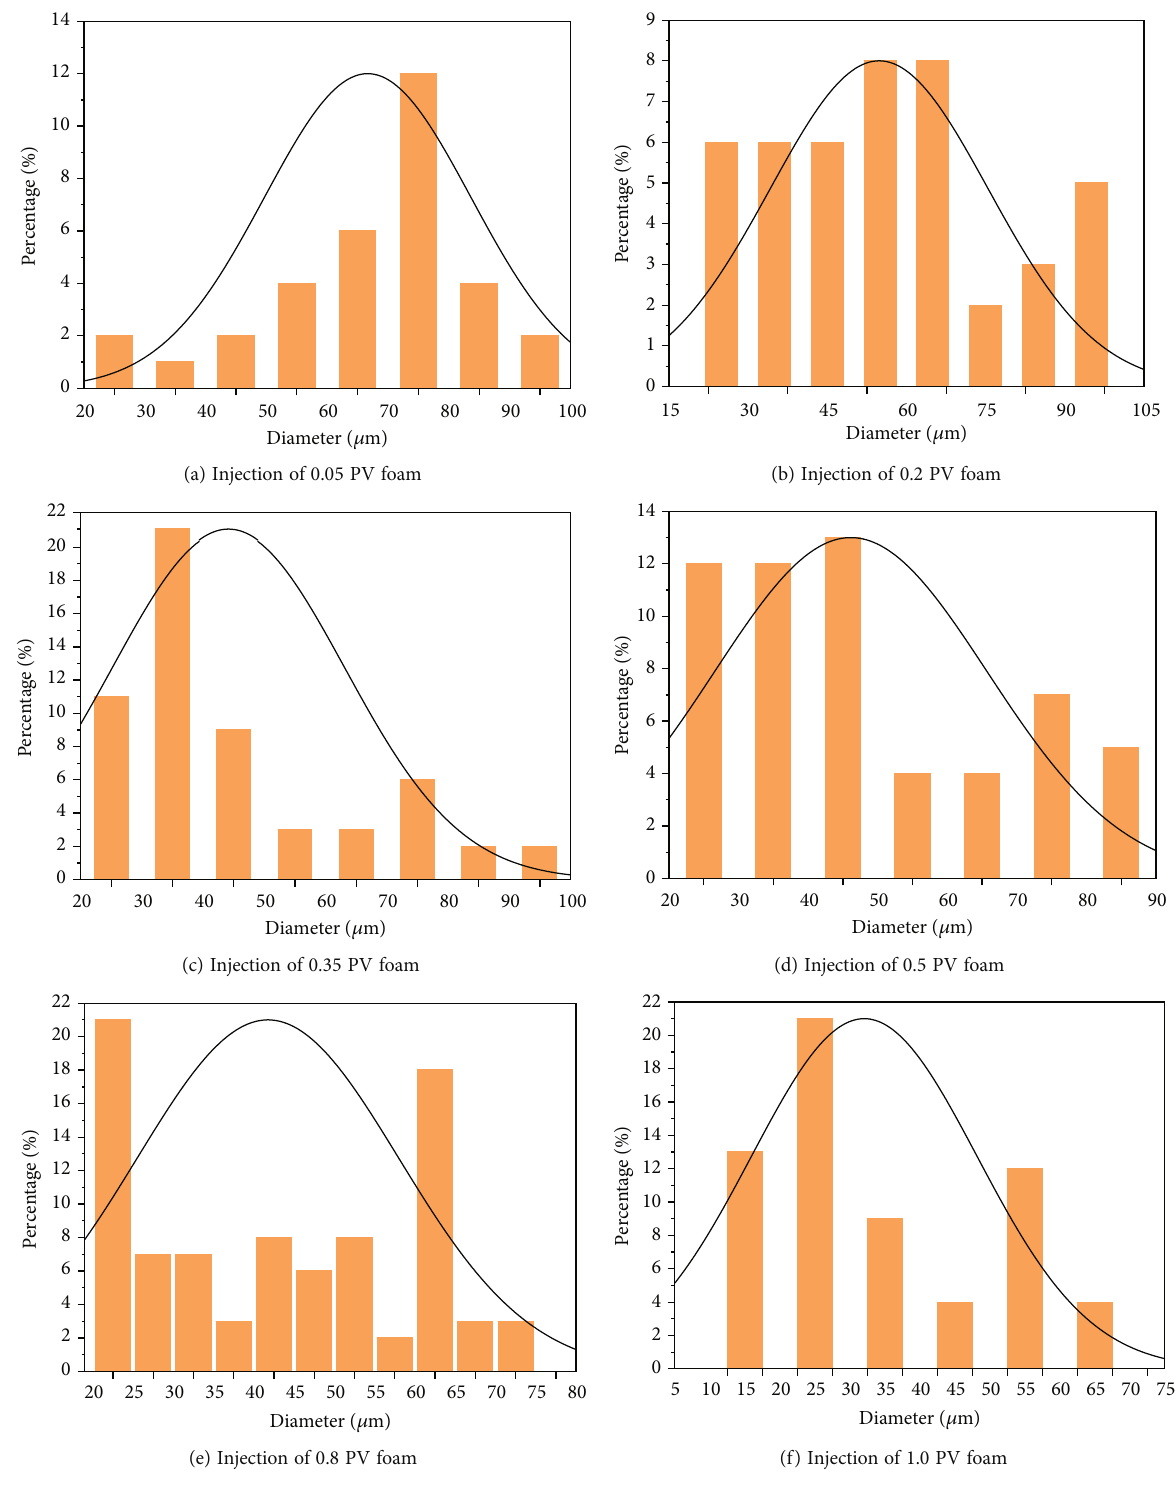
Figure 9: Emulsi fi ed particle size distribution of oil droplets at di ff erent injection